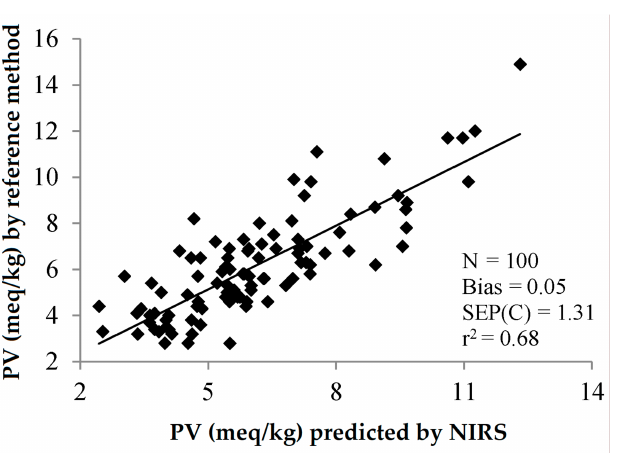
Figure 10. Validation exercise for the determination of the peroxide value of olive oil by PLS-NIRS using all the wavelengths between 400 and 2500 nm